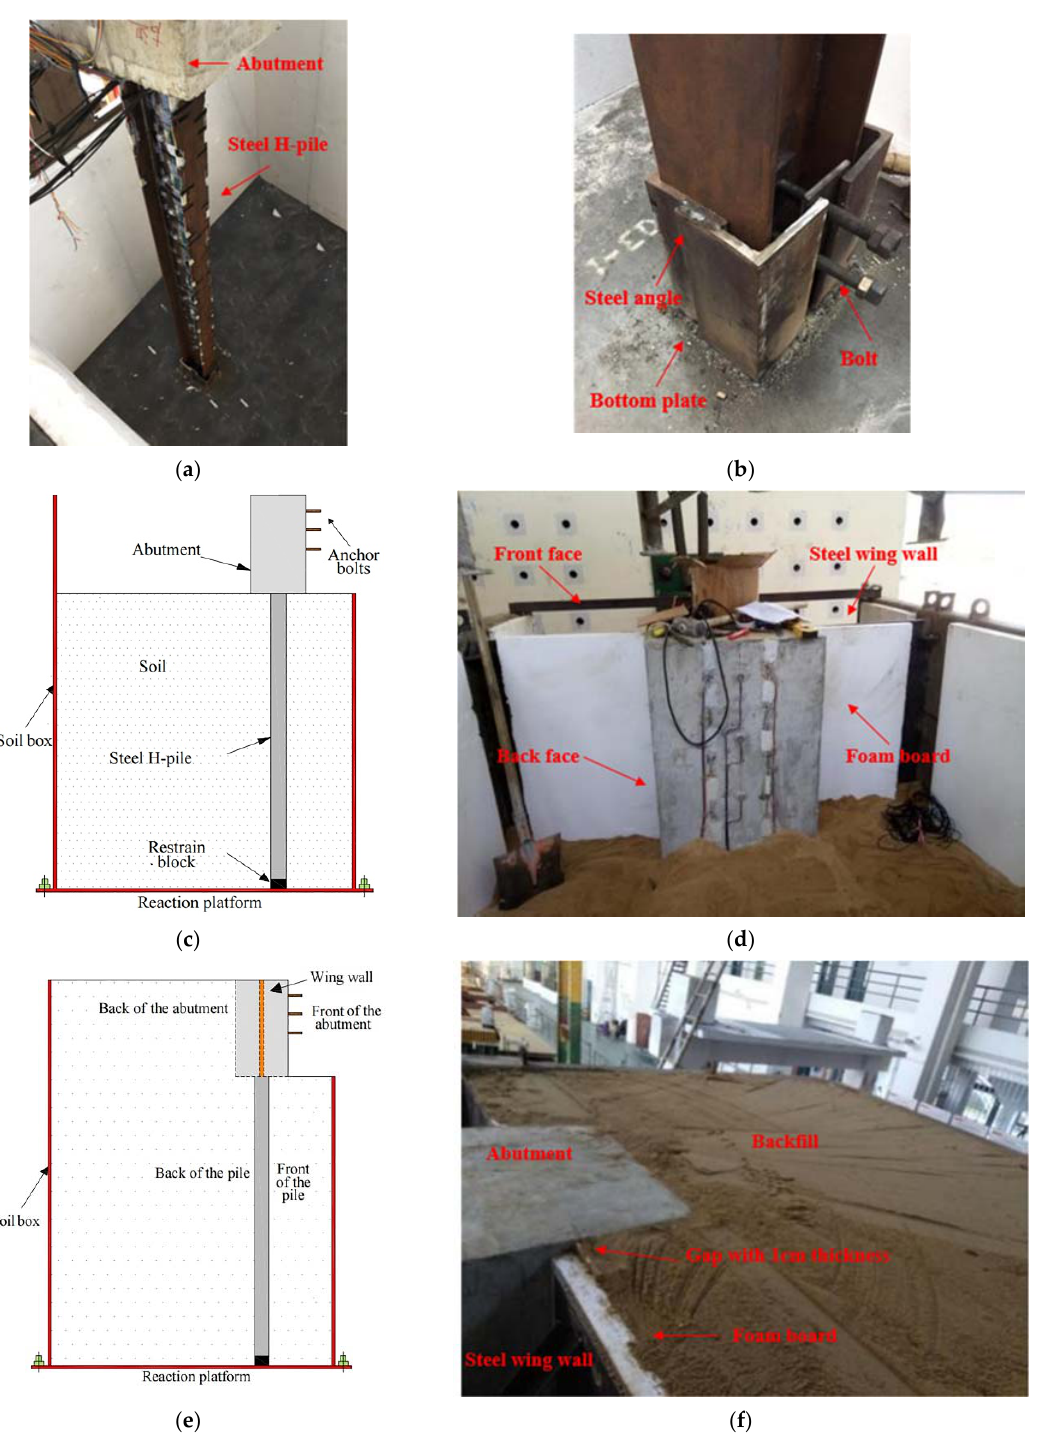
Figure 4. The process of soil filling. ( a ) The installation of specimen. ( b ) Details of the pile-toe. ( c ) The filling up to 3 m. ( d ) Photo for filling the soil of backfill. ( e ) Fully filled. ( f ) Photo for fully filled.